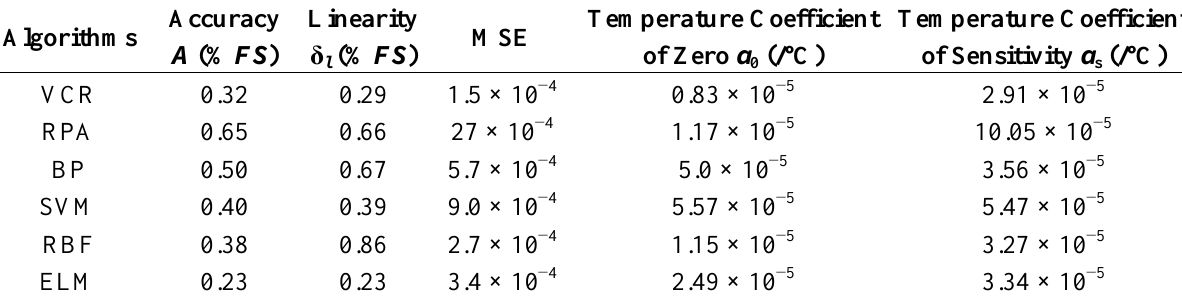
Table 4. Performances of sensor calibrated by algorithms using 4 × 6